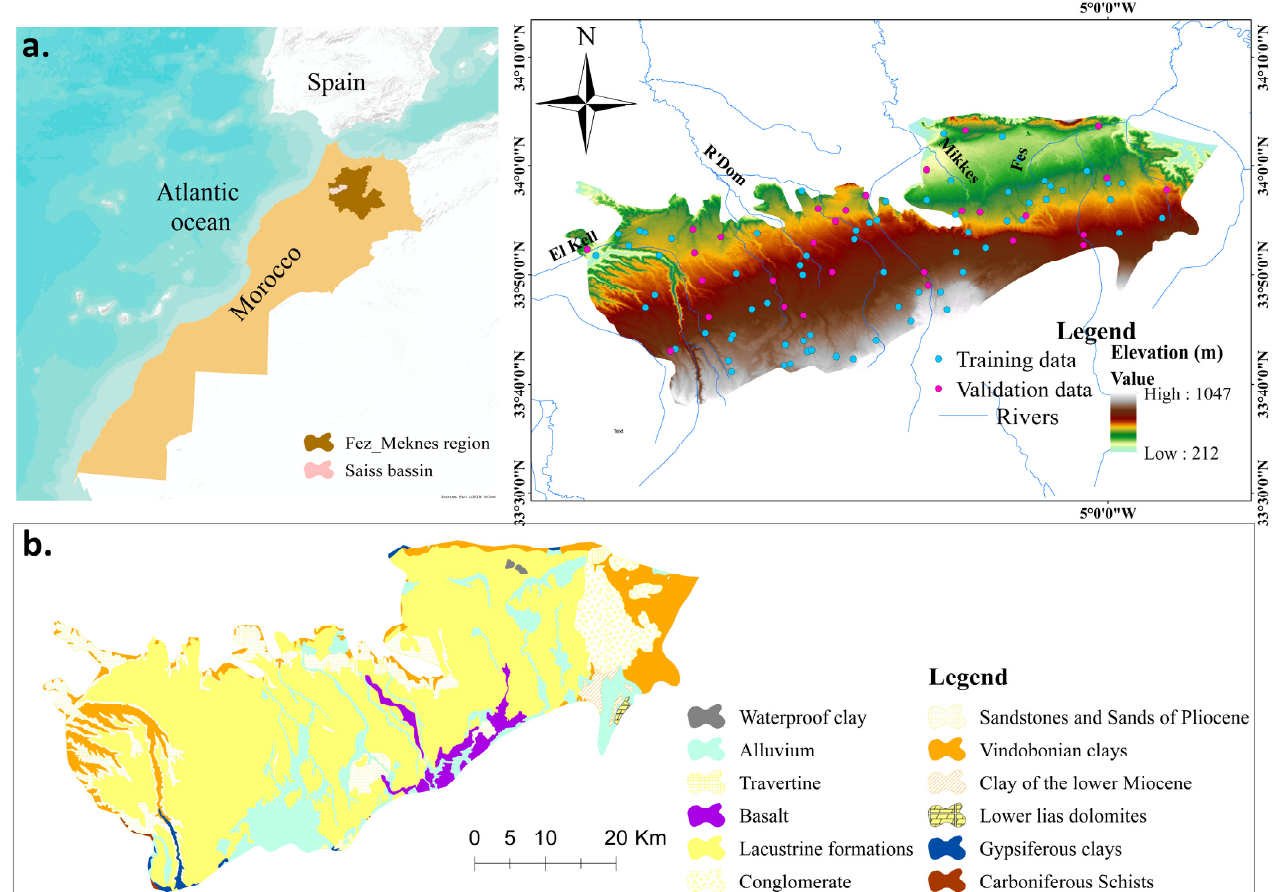
Figure 1. Location and geological map of the Saiss basin, ( a ) location of the study area, Fes-Meknes region, Morocco. ( b ) Geological map of the studied area (modified from [36]).